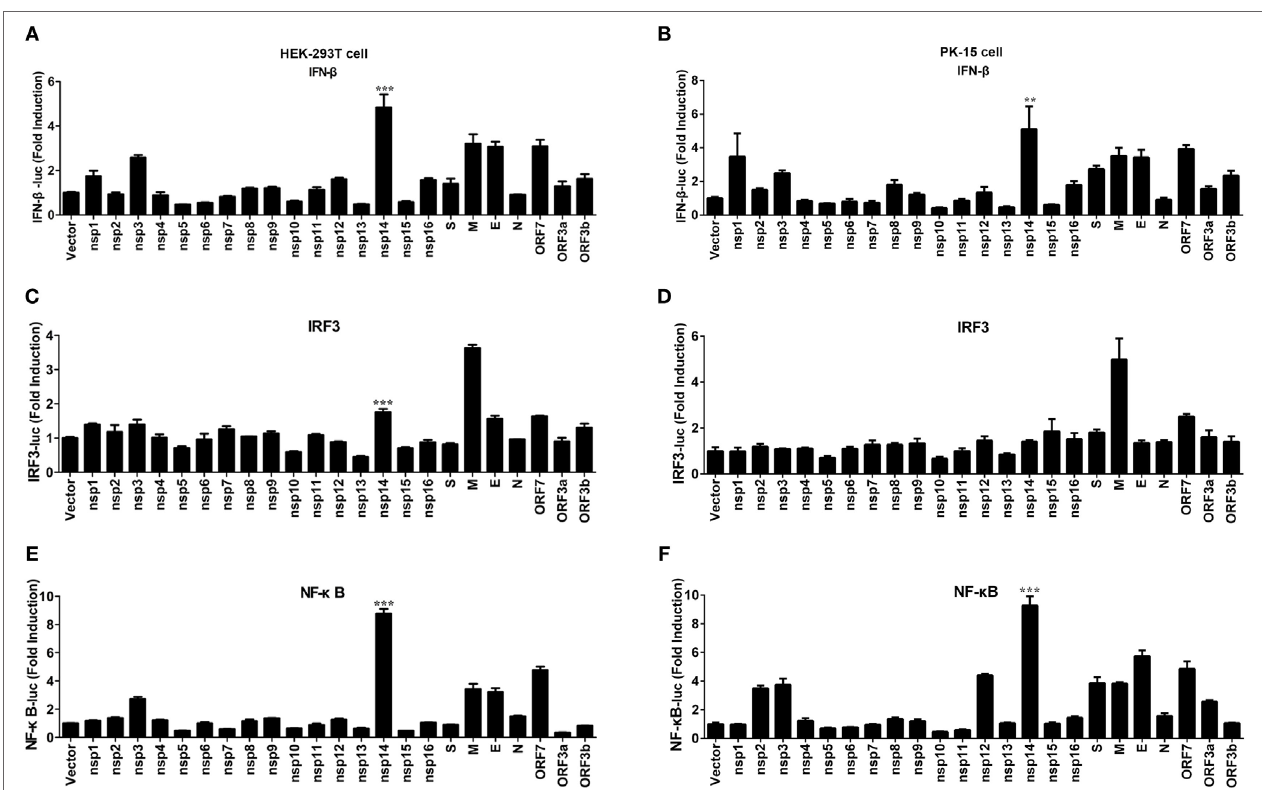
FigUre 2 | Effect of transmissible gastroenteritis virus (TGEV) proteins on IFN- β , IRF3, and NF- κ B promoter. HEK-293T cells were cotransfected with pRL-TK and IFN- β -Luc (a) , IRF3-Luc (c) , or NF- κ B-Luc (e) together with each expression plasmid of TGEV proteins. Also, PK-15 cells were cotransfected with pRL-TK and IFN- β -Luc (B) , IRF3-Luc (D) , or NF- κ B-Luc (F) together with each expression plasmid of TGEV proteins. The cell lysates were harvested for dual luciferase assays at 30 h post-transfection. Values are the mean ± SD of three independent tests. *** P < 0.001 or ** P < 0.01 compared with empty vector